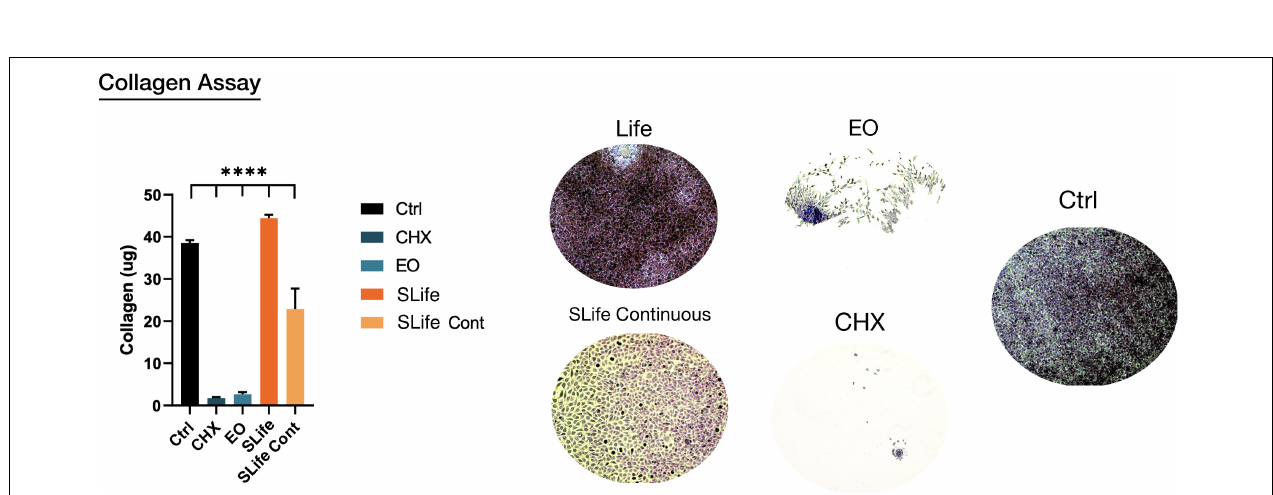
FIGURE 5 | Representative samples showing total collagen (ruby red stain color) deposition in each group. Areas of cell exfoliation appear as white background. ****Designates highly significant difference ( p < 0 . 001) to control.